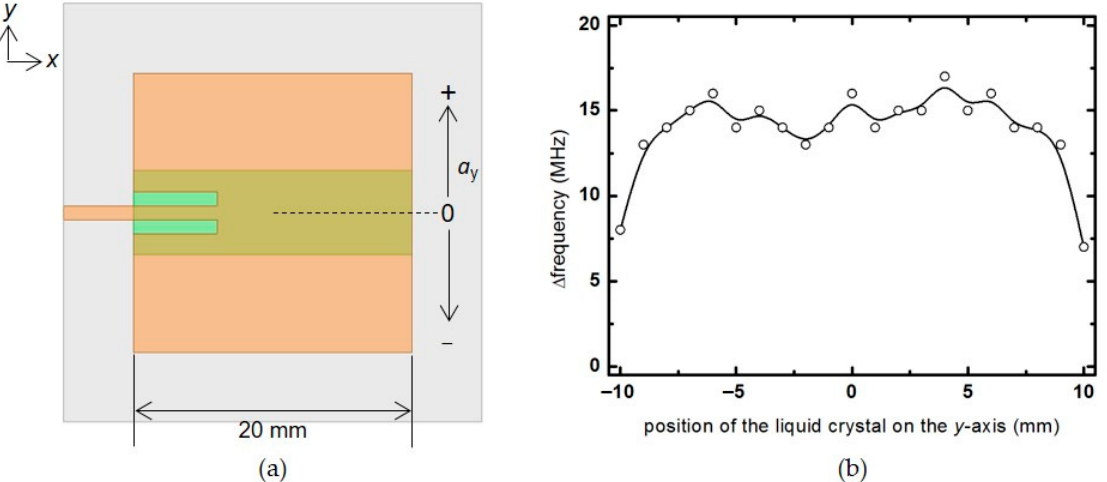
Figure 7. ( a ) Top view of the patch antenna showing the liquid crystal moving in the y -axis. ( b ) Frequency change rate according to the position of the liquid crystal in the y -direction.